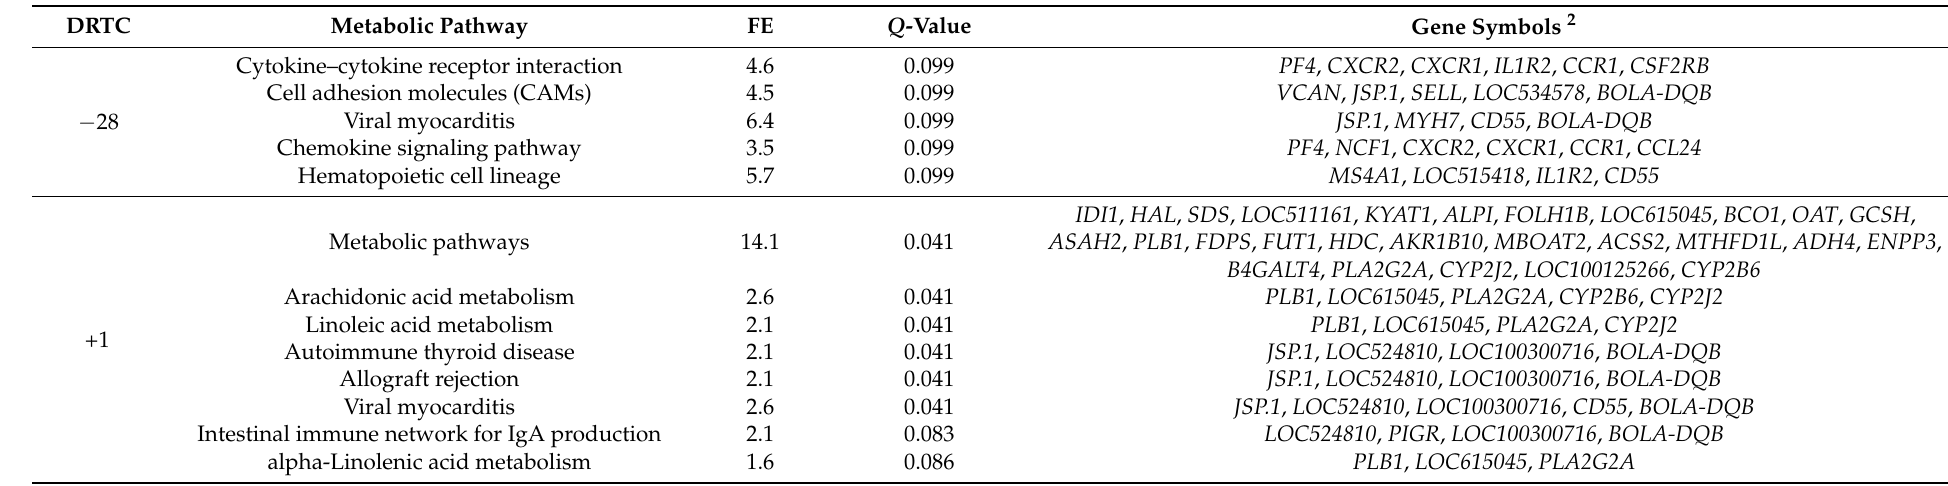
Table 5. Kyoto Encyclopedia of Genes and Genomes metabolic pathways enriched within the genes with significant or marginal evidence of differential expression in liver samples from cows more or less resistant to lipid-related metabolic disorders 1